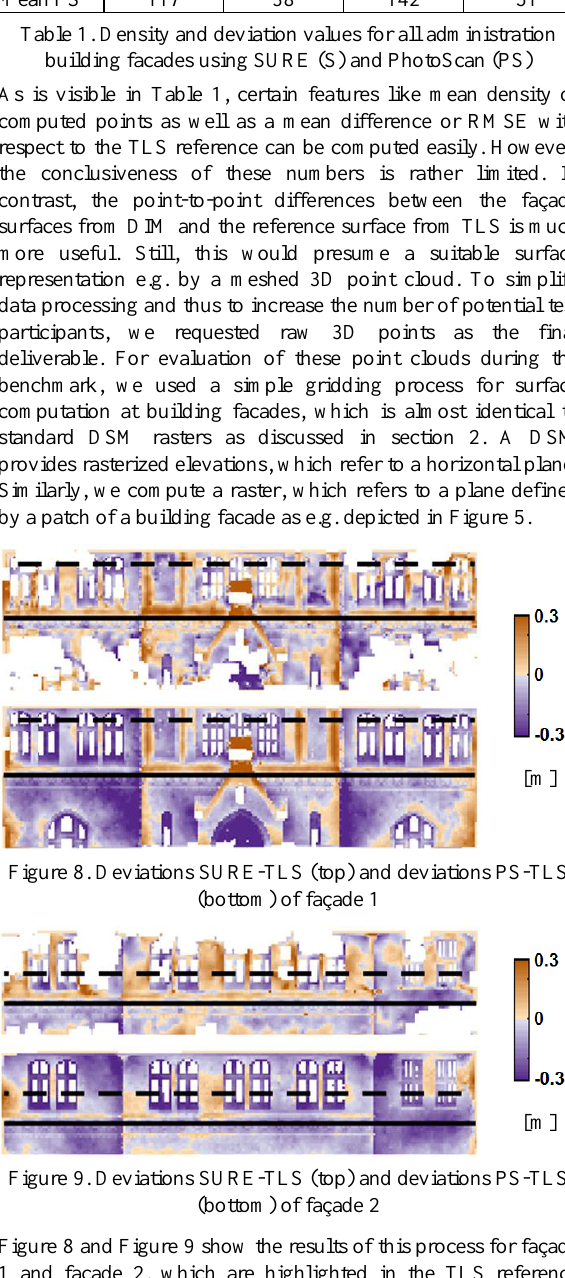
Figure 5. Point cloud from TLS for building “Verwaltung” with overlaid façade patches and profiles